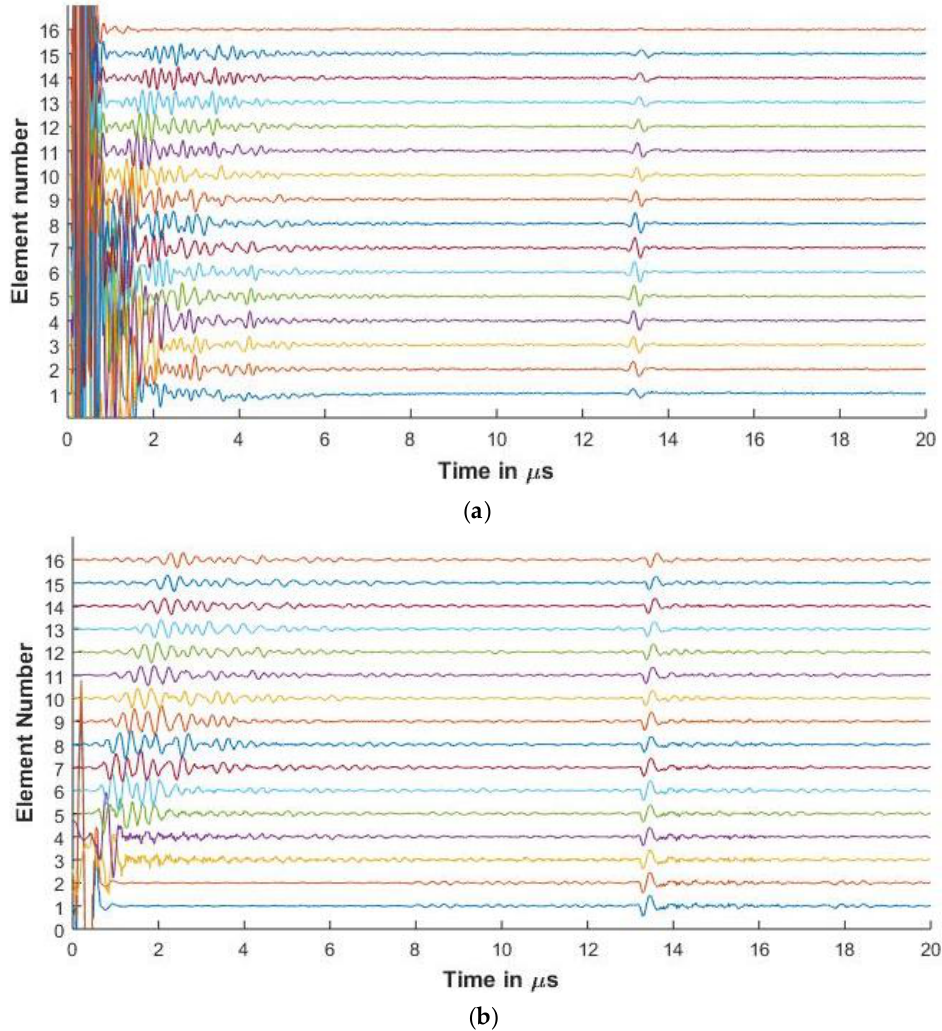
Figure 9. ( a ) Experimental FMC signals obtained for CFRP with 5 MHz 16 element array ( b ) Simulated FMC signals for CFRP with 5 MHz 16 element array.